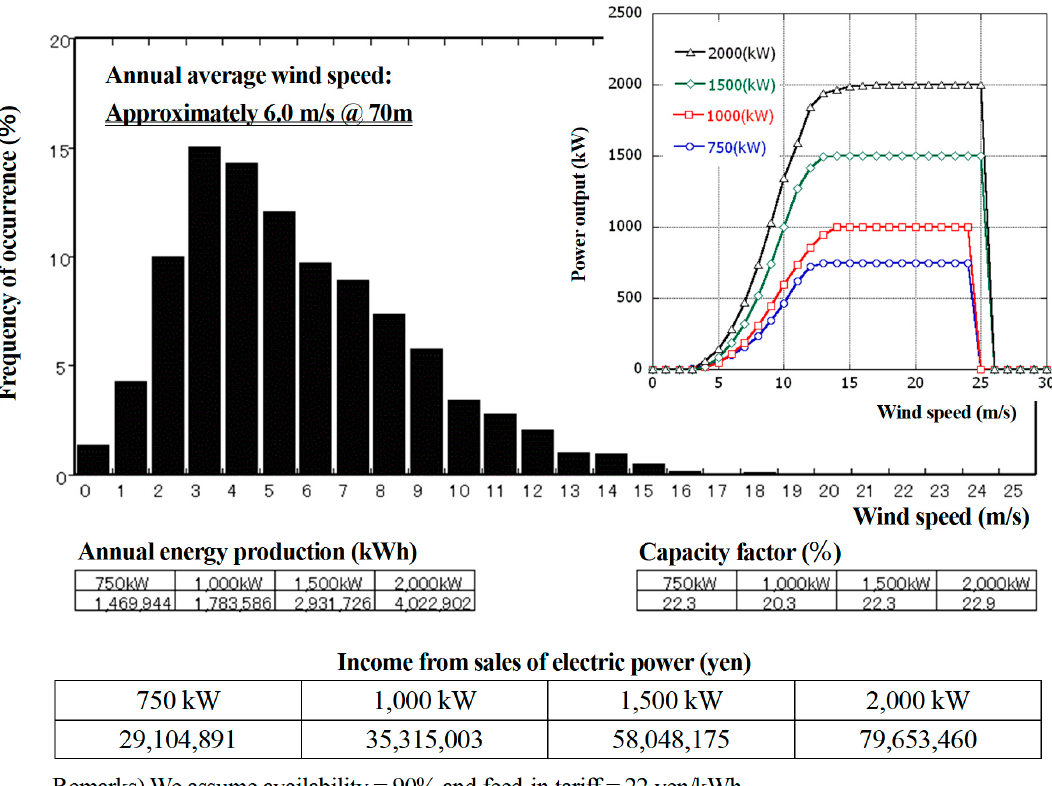
Figure 15. Results of a preliminary calculation of economic feasibility for the case of one wind turbine (hub height = 70.0 m), based on the MSM-S GPV data from the location labeled GPV1 in Figure 12.